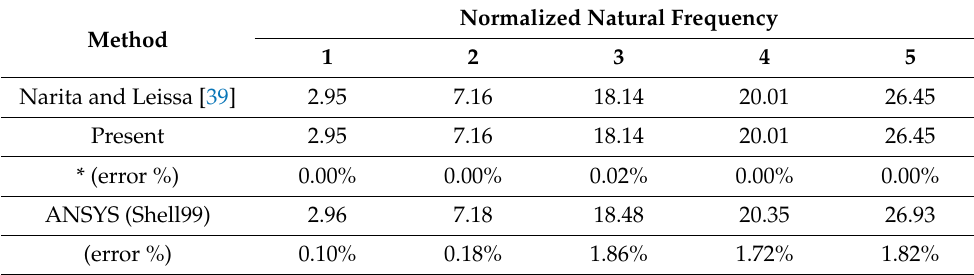
Table 2. Normalized natural frequencies of thin square glass/epoxy composite cantilever plate with fiber angle equal to 30 ◦ ( a / h = 150).